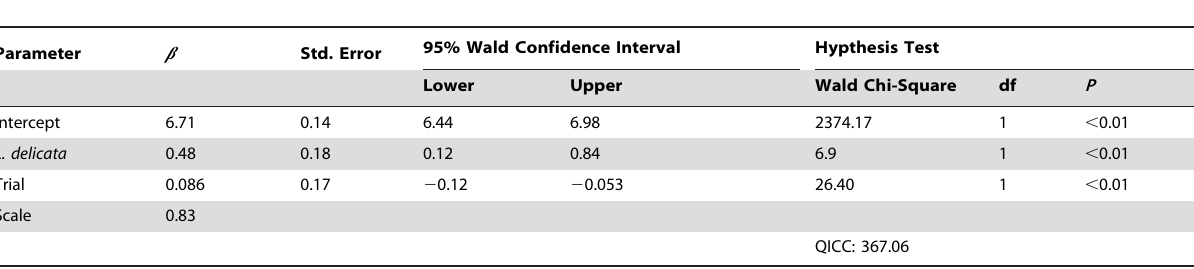
Table 1. Species differences in mean latency to the reward across 15 maze trials.